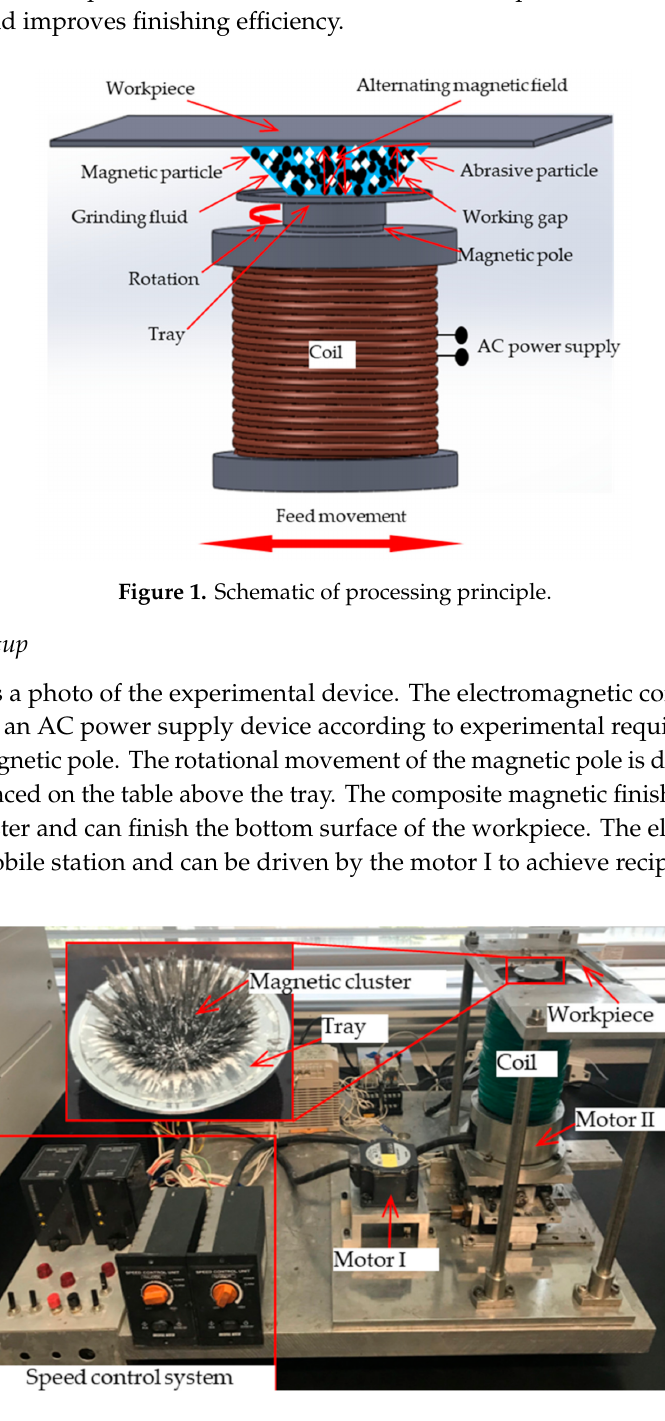
Figure 2. External view of the experimental